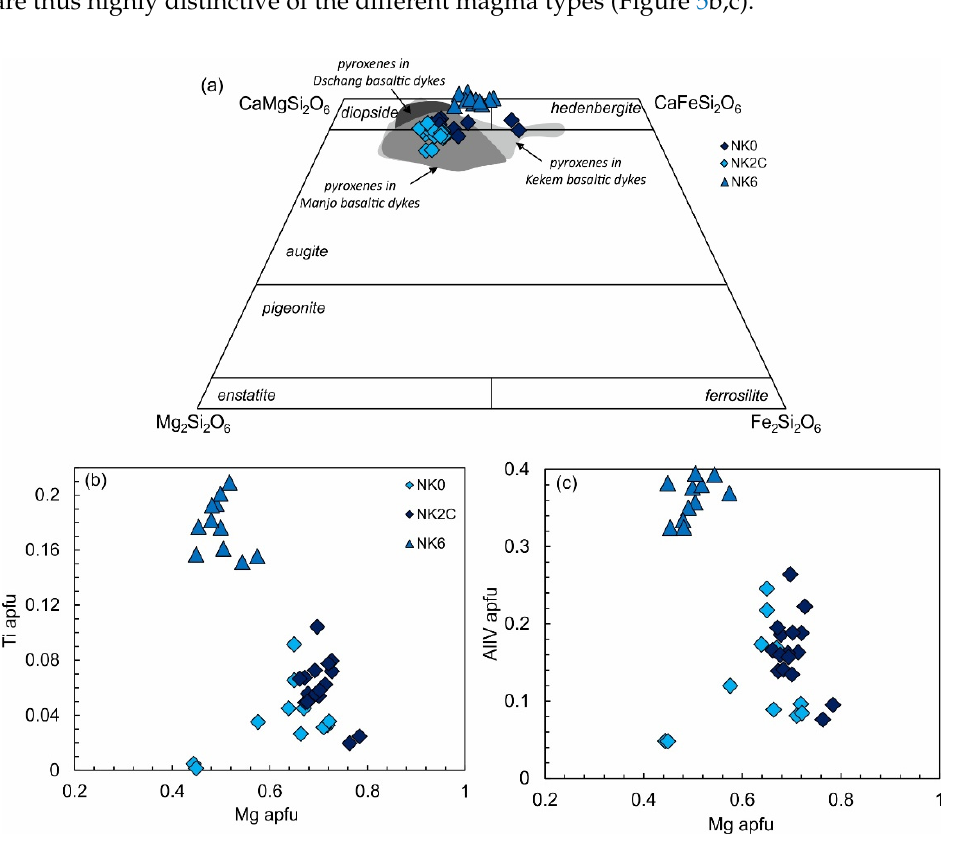
Figure 5. ( a ) Pyroxene compositions projected in the Ca-Mg-Fe diagram for the Njimom dykes. The data of clinopyroxenes of basaltic dykes from the Kekem, Dschang, and Manjo [5–7] are shown for comparison. ( b ) Ti vs. Mg (in apfu; atoms per formula unit) for Njimom clinopyroxenes. ( c ) Al IV vs. Mg (in apfu) for Njimom clinopyroxenes.